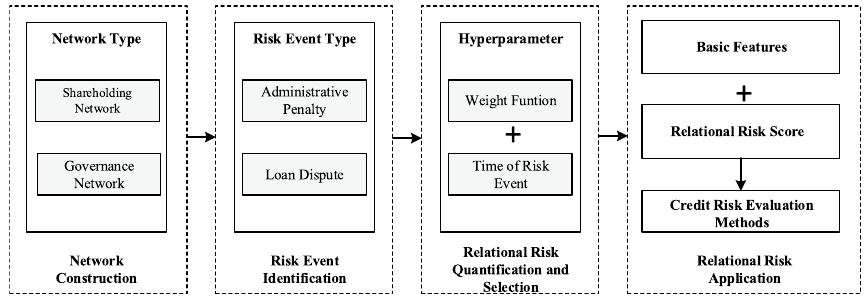
Fig. 2 Framework for quantifying relational risk based on heterogeneous information for credit risk evaluation of